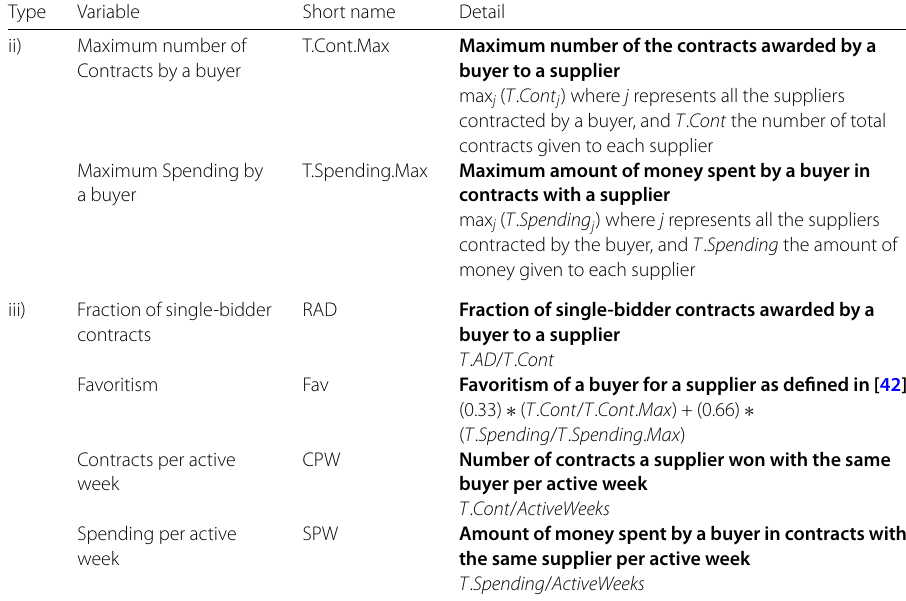
Table 2 Set of variables designed to assess buyer features and corruption risk. Variables of type ii) describe features of the buyers. Variables of type iii) provide information about the relationship between the buyers and suppliers. These variables are approximate versions of those proposed in [27, 28, 42], see